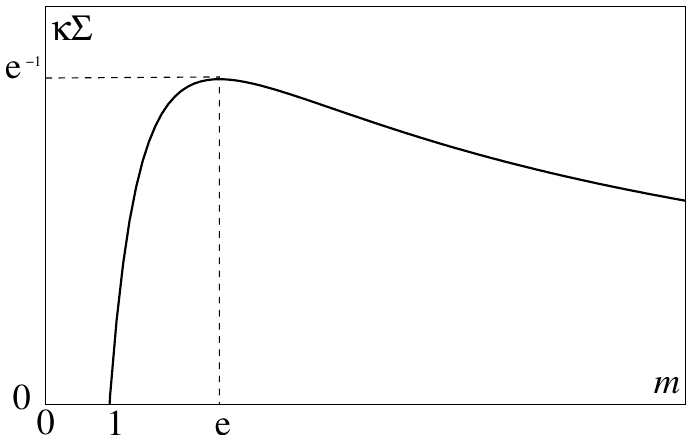
Figure 2. κ Σ vs. m -dependency defined by Equation